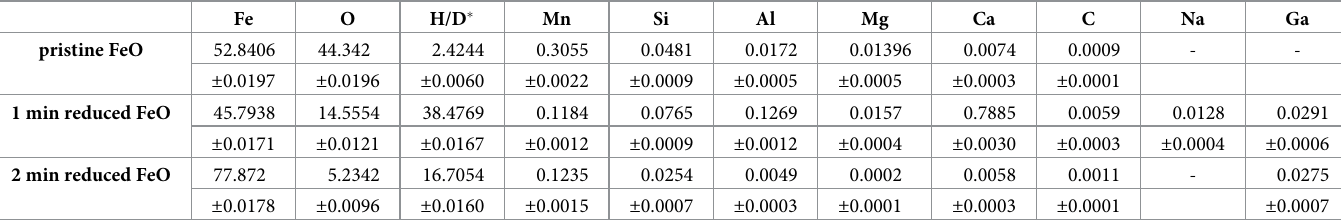
Table 1. Overall compositional analysis (at. %) of APT tips from FeO samples at before and during reduction. Fe O H/D � Mn Si Al Mg Ca C Na Ga pristine FeO 52.8406 1 min reduced FeO 45.7938 2 min reduced FeO